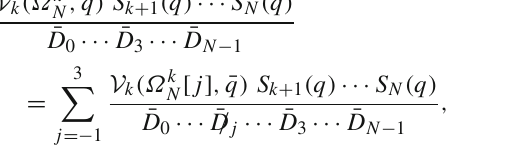
Fig. 7 Diagrammatic representation of the on-the-fly reduction rank-one counterparts on the rhs. The red crosses indicate the pinch- step (79) for an N -point open loop at step k = 2 of the dressing ing of the ¯ D j propagators in the V k (Ω k ) and V (Ω k [ j ] ) correspond, respec- recursion. The symbols V k (Ω k Since ¯ D 0 = ¯ D N , in our graphical representation the ¯ D 0 denominator k N N tively, to the rank-two polynomial on the lhs of (79) and its reduced is located on the N th